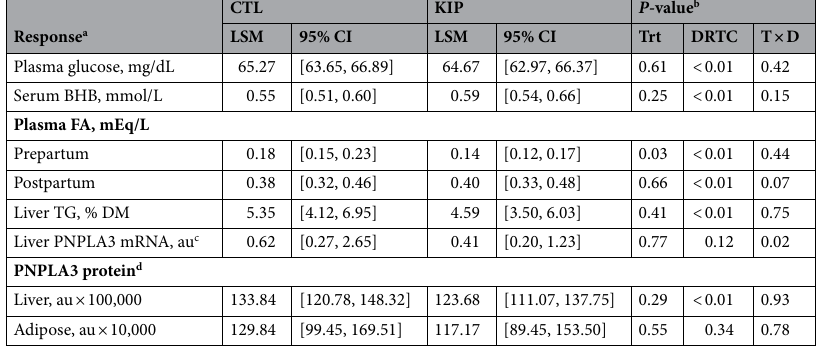
plemental Table 1. Spearman correlations between − 28 DRTC PNPLA3 protein abundance and PNPLA3 at other DRTC timepoints were significant ( P ≤ 0.05) within both tissues, with liver correlations ranging from 0.62